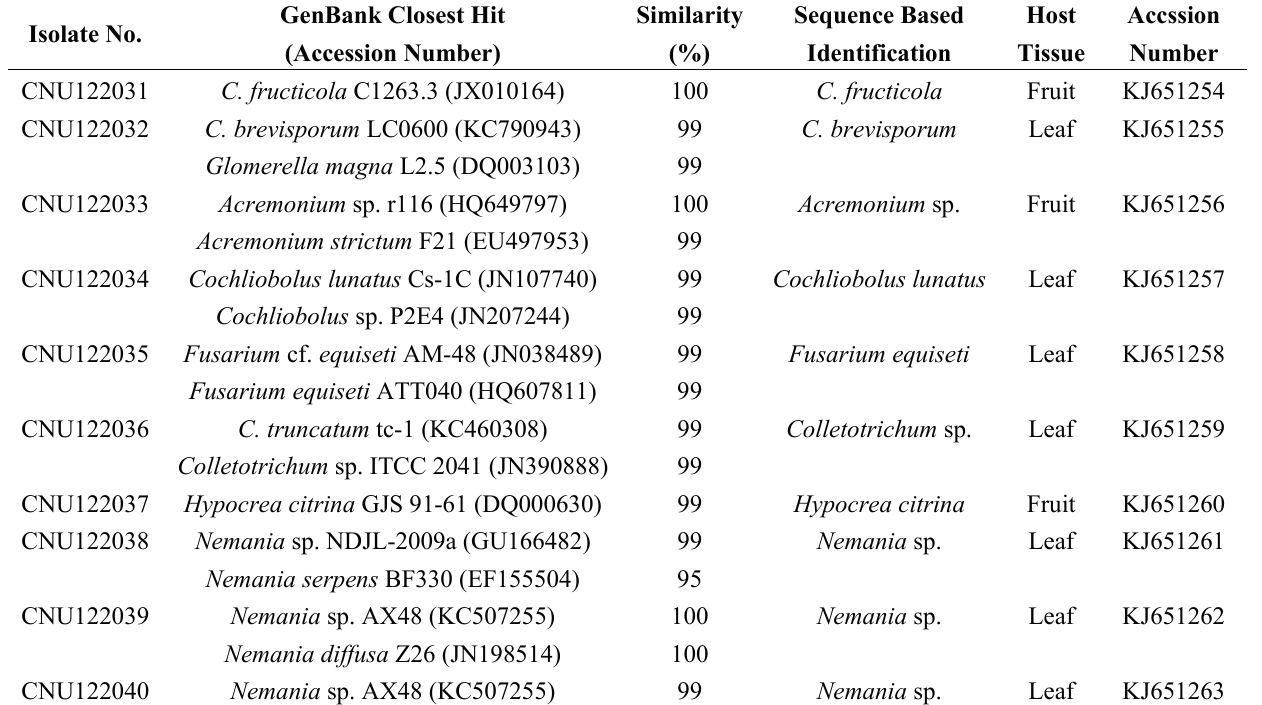
Table 1. Closest relatives of endophytic fungi isolated from Lycium chinense with BLAST search analyses based on ITS gene sequence. Isolate